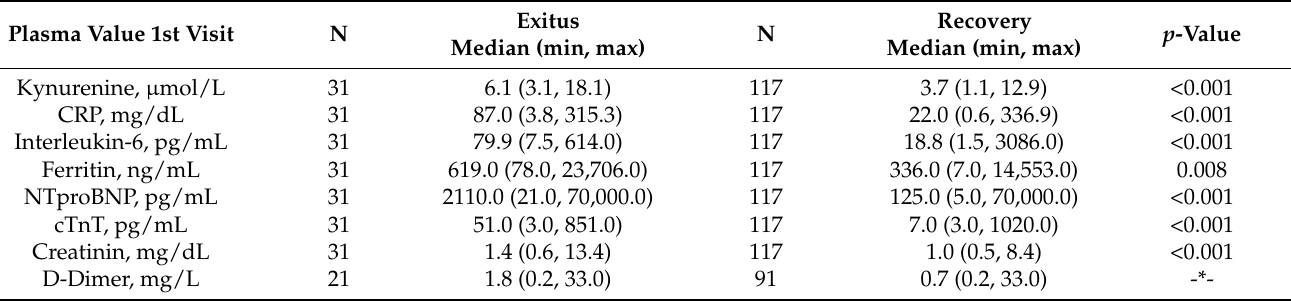
Table 2. Levels of biomarkers found between the